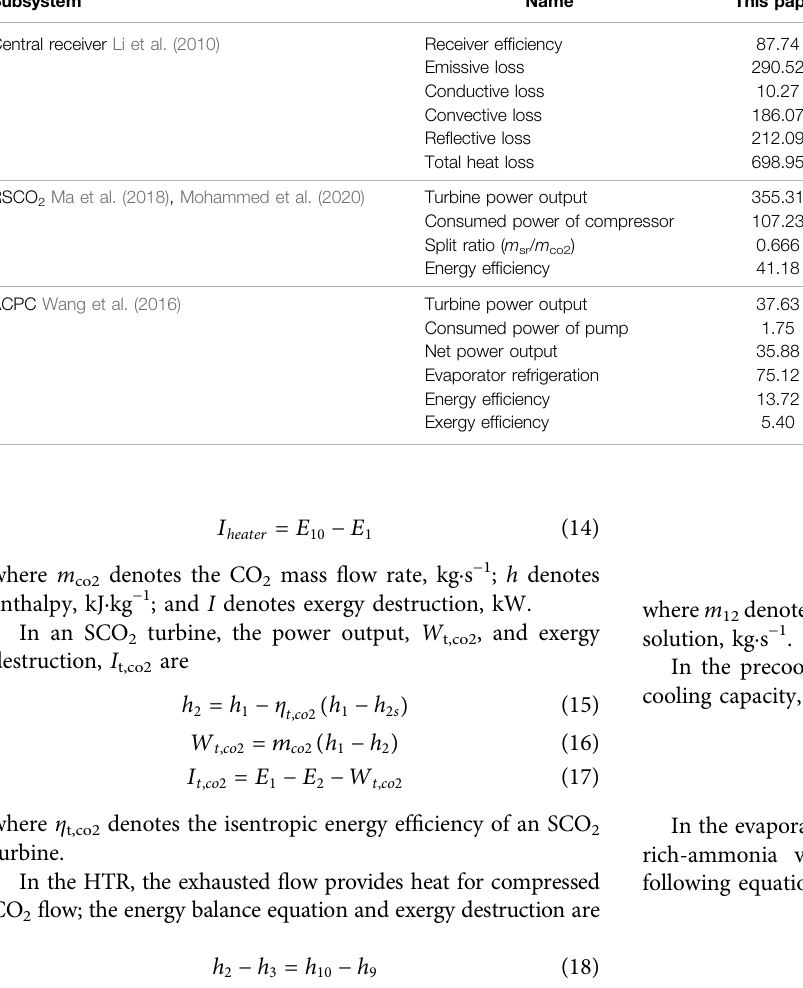
TABLE 2 | System model validation result.